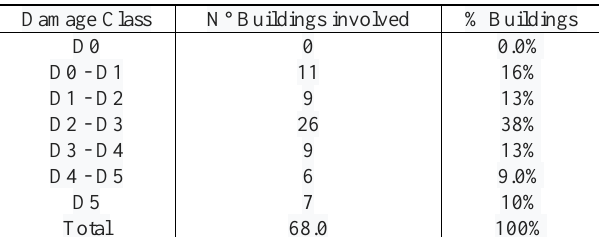
Figure 5. Distribution of the Floor typology for each SU in Campi Alto di Norcia.